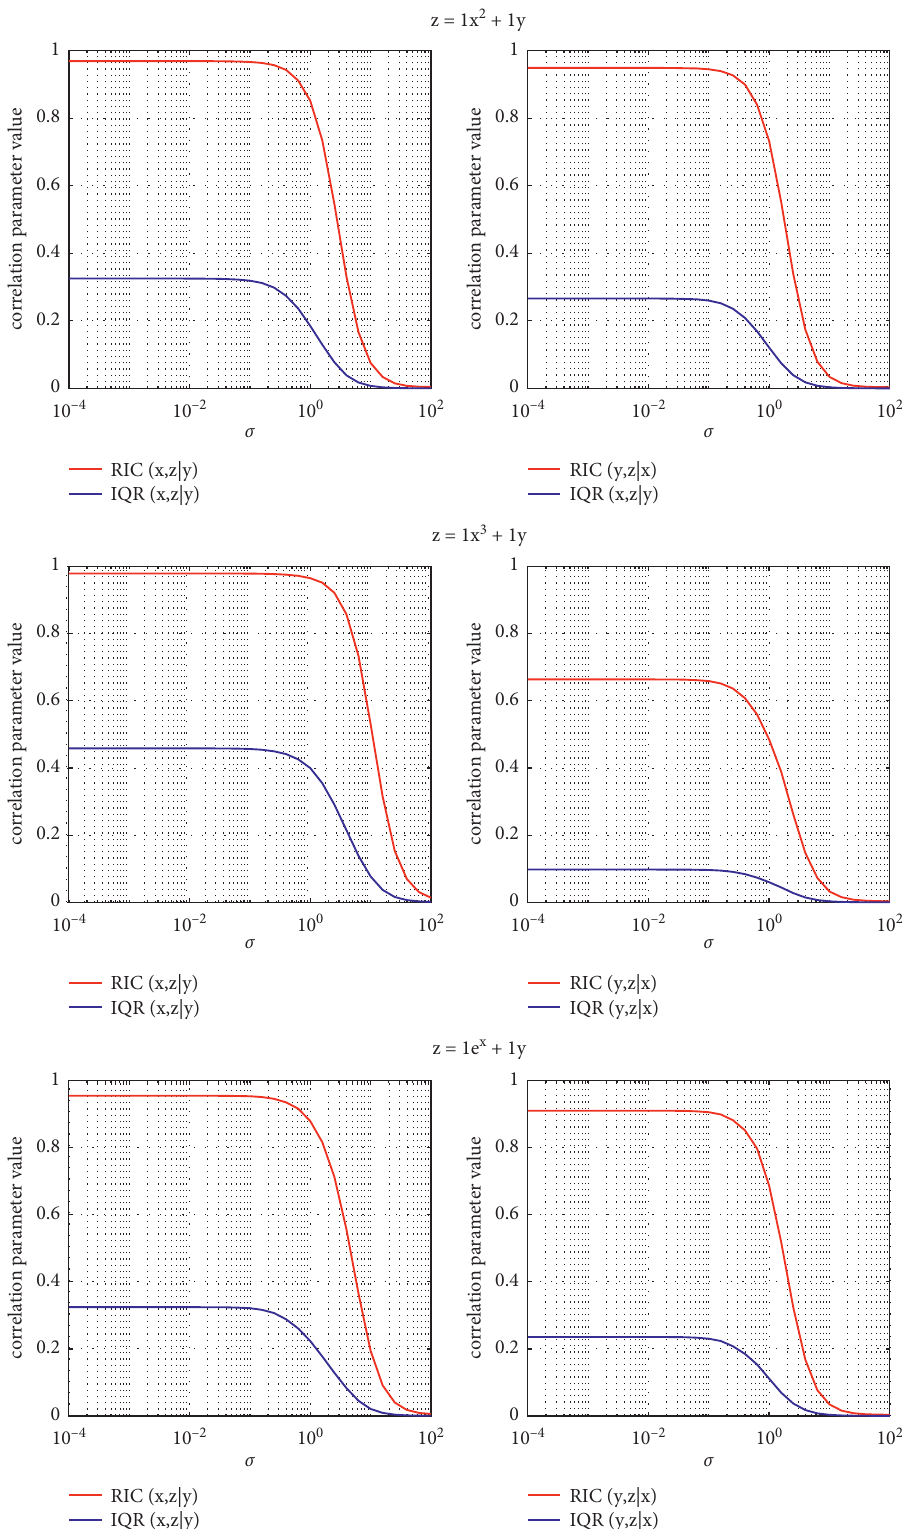
Figure 7: Comparison of RIC cond ( X , Z | Y ) and IQR cond ( X , Z | Y ) for various types of mutual influences in the presence of